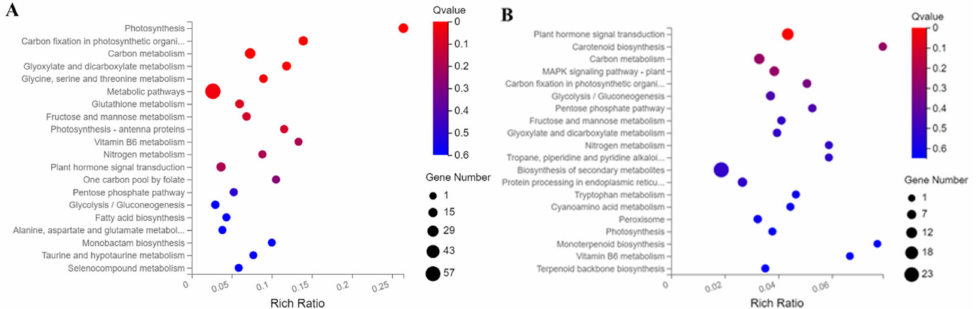
Figure 8. Bubble diagram of enrichment in KEGG pathways. ( A ) Enrichment KEGG pathways of DEGs in the brown module (480 genes). ( B ) Enrichment of KEGG pathways of DEGs in the green module (338